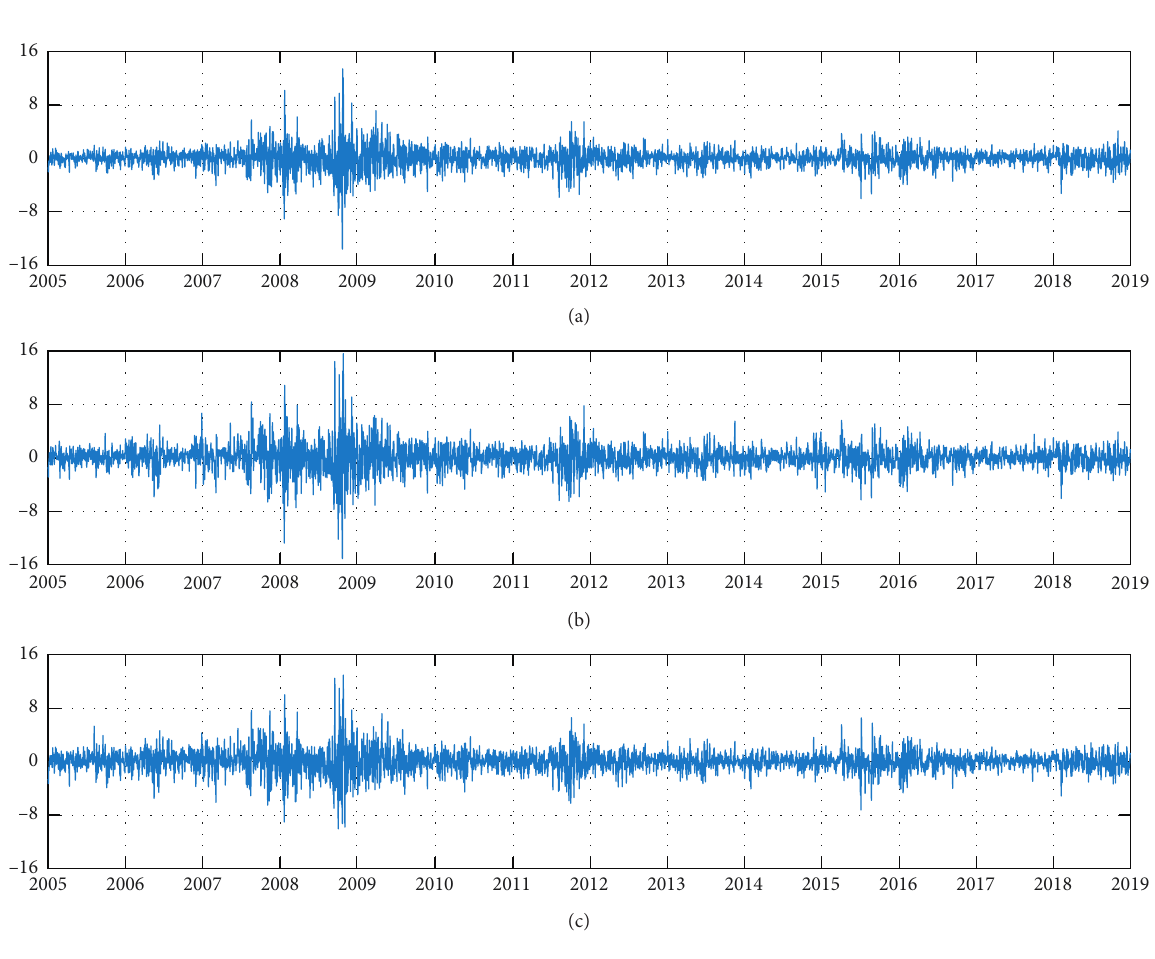
Figure 4: Return series. (a) HSI. (b) CEI. (c) CCI.